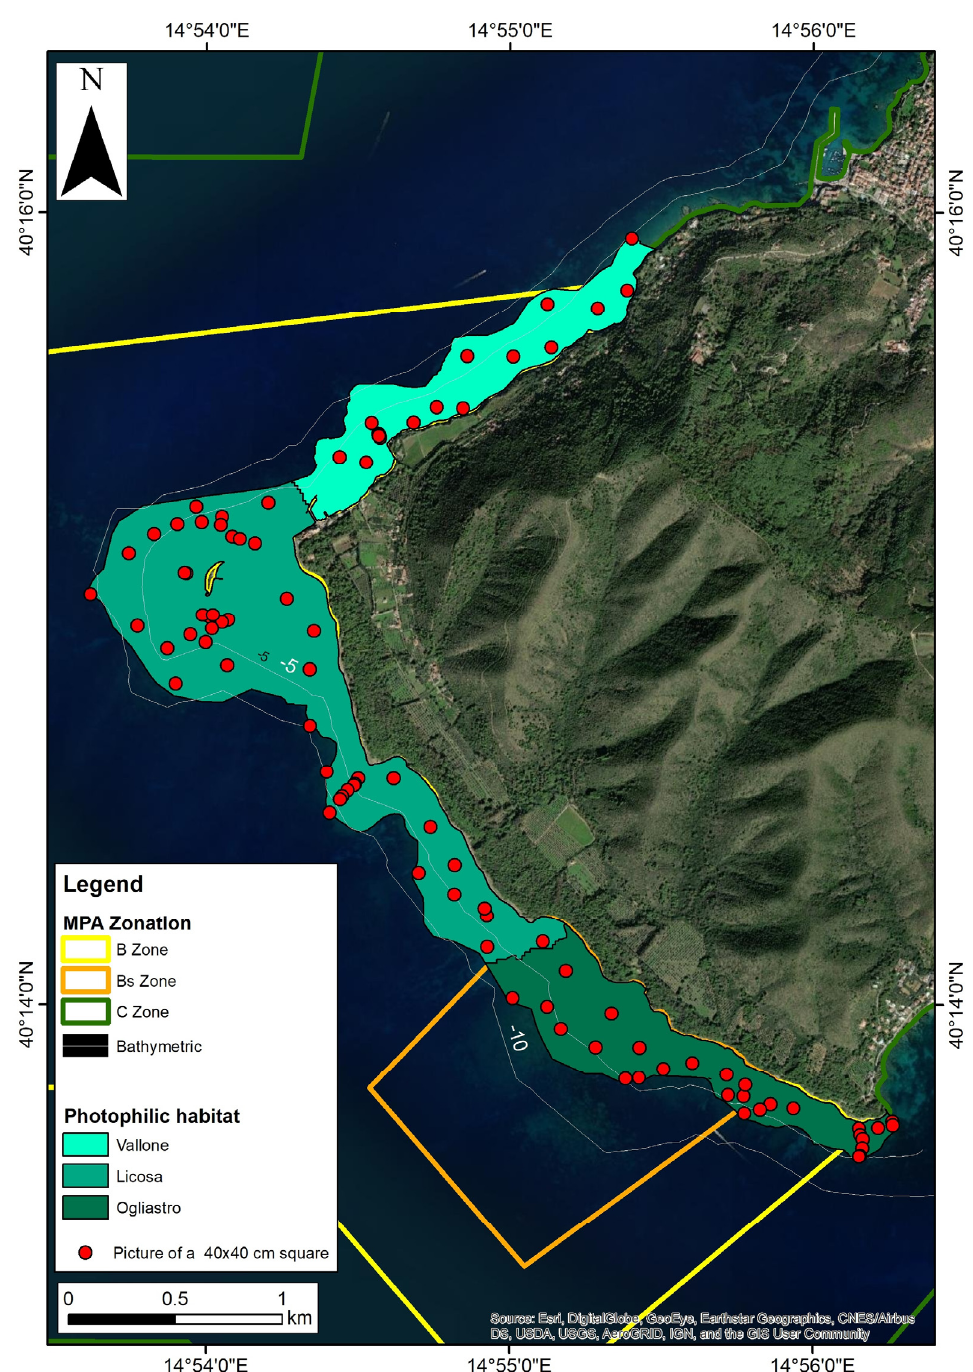
Figure 2. Map of photophilic habitat and spatial distribution of the 40×40cm quadrats/images (red dots) used for the EBK geo-statistical analysis. Photophilic habitat refers to [57]. The green scale indicates the three sites studied: Vallone, Licosa, and Ogliastro.